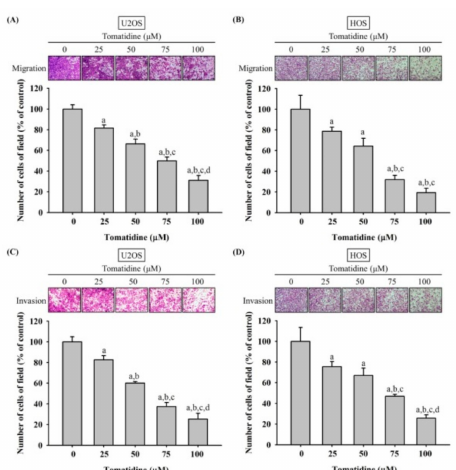
Figure 2. E ff ects of tomatidine on in vitro cellular migration and invasion of U2OS and HOS cells. Cell migration ( A and B ) and invasion ( C and D ) assays after various concentrations (0, 25, 50, 75, and 100 µ M) of tomatidine treatment for 24 h in U2OS and HOS cells were measured as described in the Materials and Methods section. Results are shown as mean ± S.D. n = 3. ANOVA analysis with Turkey’s posteriori comparison was used. (A) U2OS: F = 125.713, p < 0.001; (B) HOS: F = 56.973, p < 0.001; (C) U2OS: F = 159.838, p < 0.001; (D) HOS: F = 43.987, p < 0.001. a Significantly di ff erent, p < 0.05, when compared to the control. b Significantly di ff erent, p < 0.05, when compared to 25 µ M. c Significantly di ff erent, p < 0.05, when compared to 50 µ M. d Significantly di ff erent, p < 0.05, when compared to 75 µ